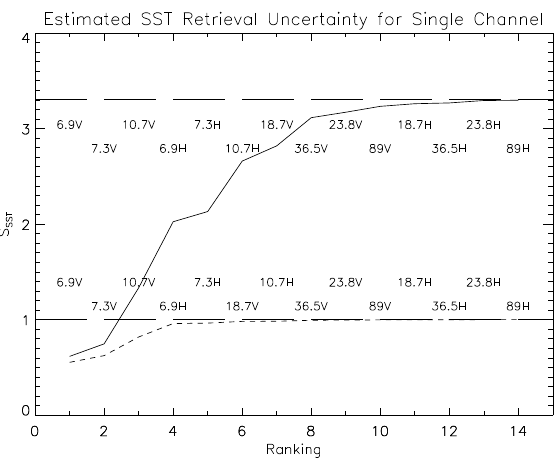
Figure 6. Estimated SST retrieval uncertainty for a single-channel retrieval from information content analysis. The upper set of channels and solid line come assume a four-variable retrieval vector and prior SST uncertainty of 3.31 K. The lower set and dashed line assunme a five-variable retrieval vector, in which cloud liquid water is additionally accounted for, and a priori SST uncertainty of 1.0 K. The prior uncertainty values in each case are shown in long-dashed lines.